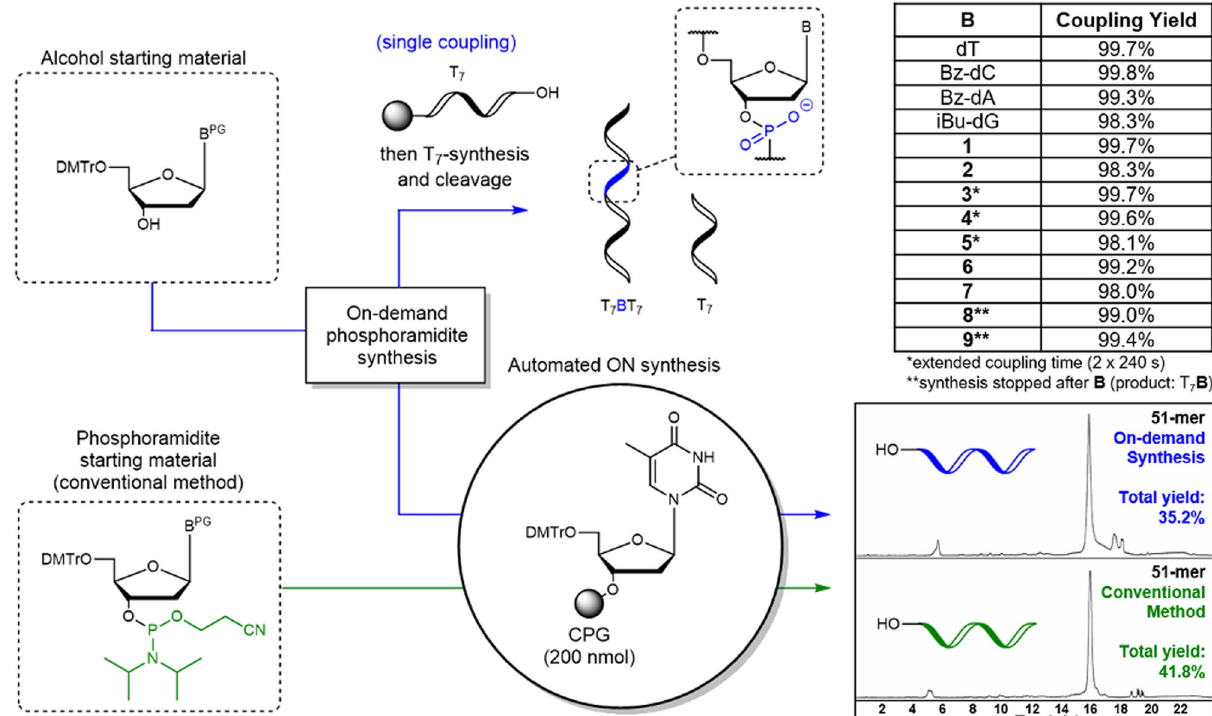
Fig. 4 Application of on-demand synthesized phosphormamidites in oligonucleotide synthesis. Top: Single coupling of phosphoramidites prepared on- demand to a resin-bound T 7 followed by elongation with another T 7 segment and cleavage from the resin. Bottom: Synthesis of a 51-mer using solely the on-demand approach. HPLC chromatograms of crude material: by conventional solid-phase synthesis with stored phosphoramidites (green) or with the on- demand synthesized phosphoramidites (blue). 51-mer sequence: 5 ′ CCG CTT TCT AGT TCG TCC TCC ATA ATT AAT TTC CTA GAG TCC TAC GTG CTC 3 ′ . B (on-demand synthesized phosphoramidite), CPG (controlled pore